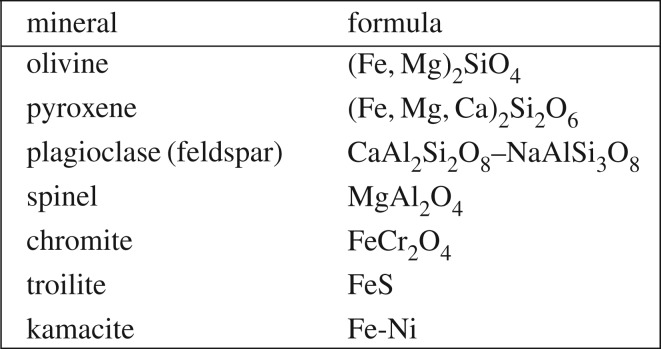
Formulae for common minerals in chondrules [200], table 1.